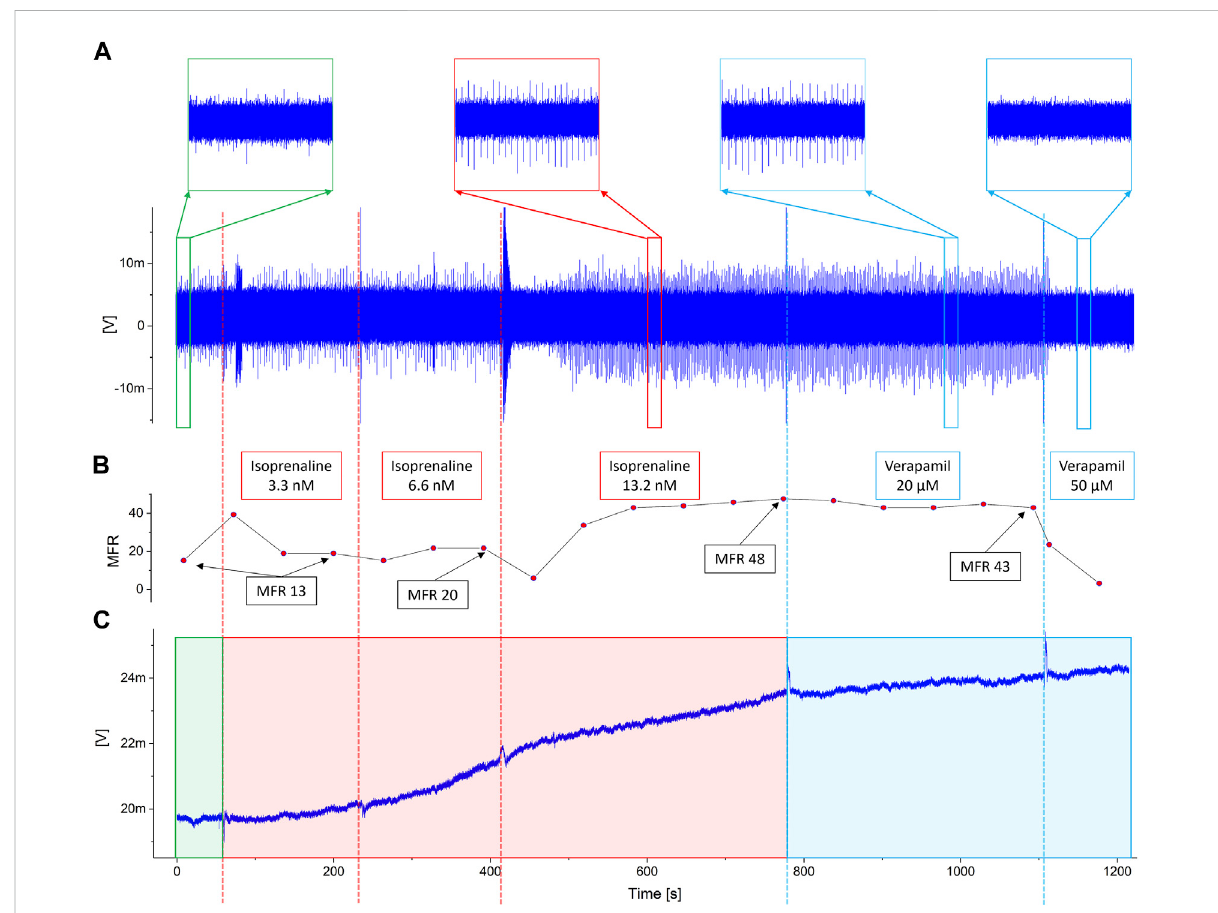
FIGURE 4 Experimentalresults.ThedottedverticallinesrepresentthetimestampsoftheadditionofIsoprenaline(red)andVerapamil(blue). (A) Theoutput of the channel for cellular electrical activity shows how noticeable variations occur only when the maximumdoses of drugs have been reached. This is also con fi rmed observing the inset, in which detailed views of the signal during the basal (green square), the highest dose of isoprenaline (red square)andVerapamil(bluesquares)areshown. (B) MeanFiringRateduringthewholepharmacologicalexperiment.ThelabelsspecifytheMFR valueattheendofeachphase. (C) OutputofthepH-sensitivechannel.Interestingly,noticeablechangesintheactivitycanbeappreciatedrightafter the administration of the lower doses of both isoprenaline and